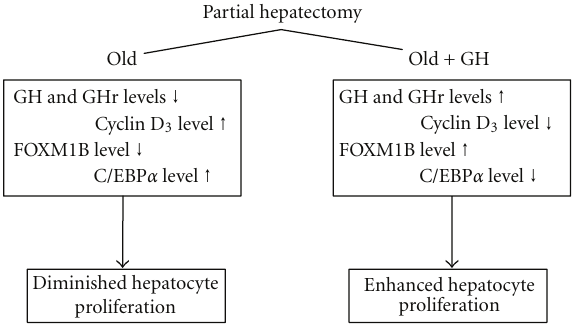
Figure 7: E ff ect of age on the e ffi cacy of growth hormone induced activation of the pathway resulting in hepatocyte proliferation. Data derived from [34].